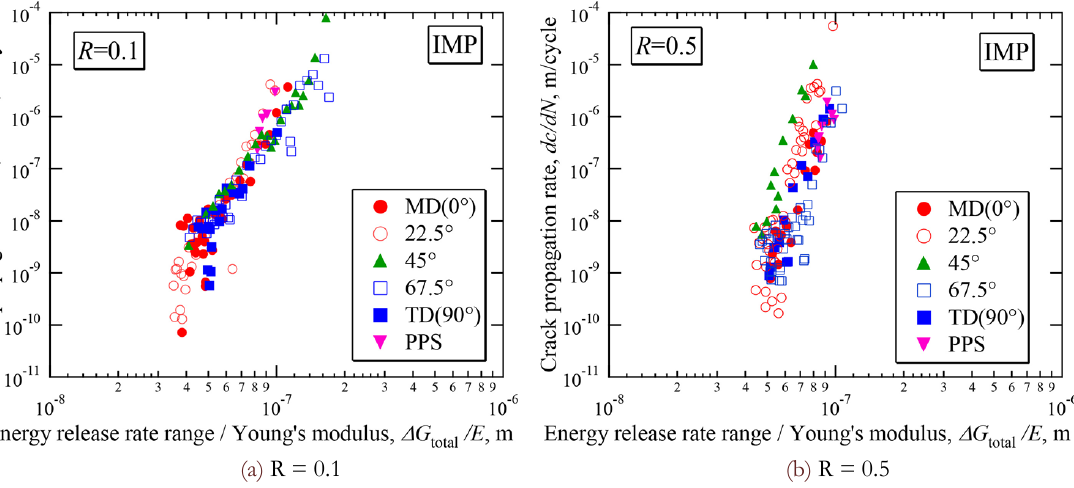
Figure 9: Relation between crack propagation rate and total energy release rate range divided by Young’s